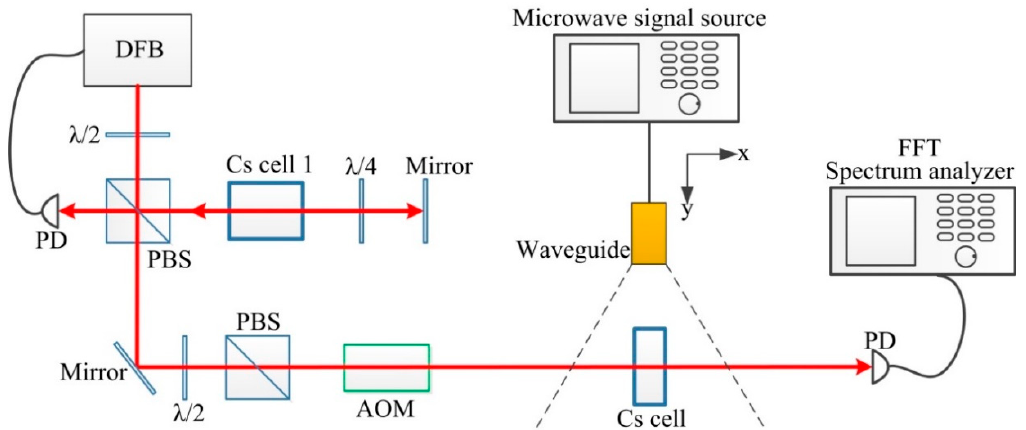
Figure 2. Experimental setup of quantum-based method. Cs cell 1 was used to generate saturation absorption spectroscopy. Cs cell was used to measure microwave magnetic field. The frequency of the laser was locked by the saturation absorption system.